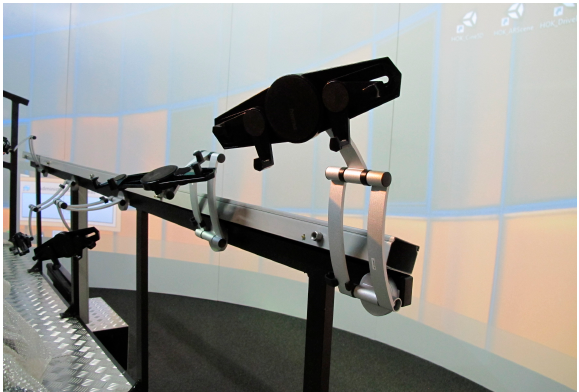
Figure 3. An image showing some of the air and water dispensers, facing the audience located in the first row of seats.